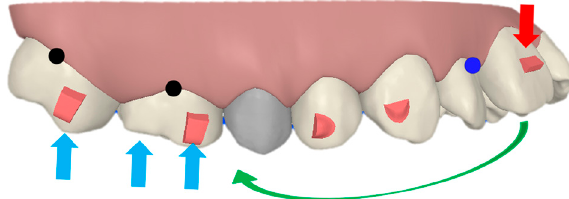
Figure 15. The extrusive force and intrusive force generated by reciprocal